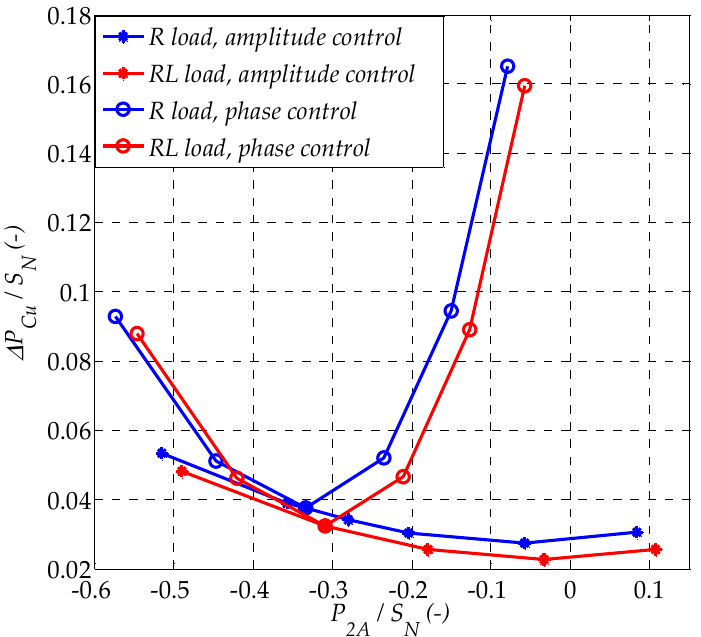
Figure 13. Load losses of the transformer with amplitude or phase control as a function of the active power value of the prosumer source.